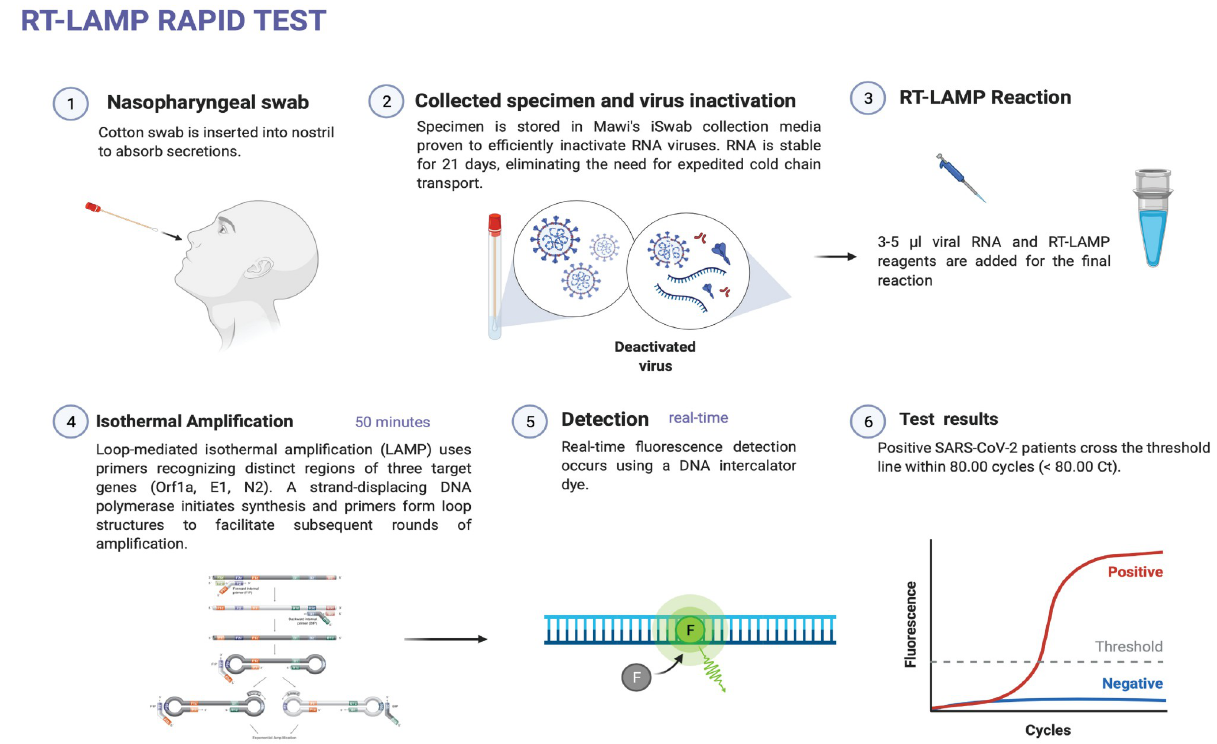
Fig 3. RT-LAMP rapid test workflow. Fig 3. Compared to a standard RT-PCR pipeline, the RT-LAMP assay provides a faster turn- around for data generation, is highly versatile, scalable on-demand, requires less workforce and presents advantages compared to rapid antigen tests Fig 4. Thus, making the assay a suitable candidate for SARS-CoV-2 detection in the context of the current COVID-19 pan- demic. Additionally, data collected in our laboratory has shown that the same assay can be used for the detection of other pathogens like treponema pallidum, Influenza Viruses, Hep- atitis virus, and more. Although the assay represents a valuable tool for the SARS-CoV-2 detection in clinical samples, significant limitations must be considered. The detection of 18S RNA indicates that human nucleic acid is present and implies that human biological material was collected, successfully extracted, and amplified. It does not necessarily suggest that the specimen is appropriate for detecting SARS-CoV-2.—Negative results do not pre- clude SARS-CoV-2 infection and should not be used as the sole basis for treatment. Opti- mum specimen types and timing for peak viral levels during infections caused by SARS-CoV-2 are not fully determined and might impact the assay. A false-negative result may occur if a specimen is improperly collected, transported, or handled.—If the virus mutates in the LAMP target regions, SARS-CoV-2 may not be detected.—Inhibitors and other types of interference may produce false-negative results—Detection of viral RNA may not translate to causation for clinical symptoms and severity of the symptoms.—The effect of vaccines, antiviral therapeutics, antibiotics, chemotherapeutic or immunosuppressant drugs has not been evaluated.